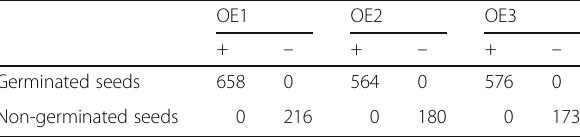
Table 1 Seed germination of progeny of three